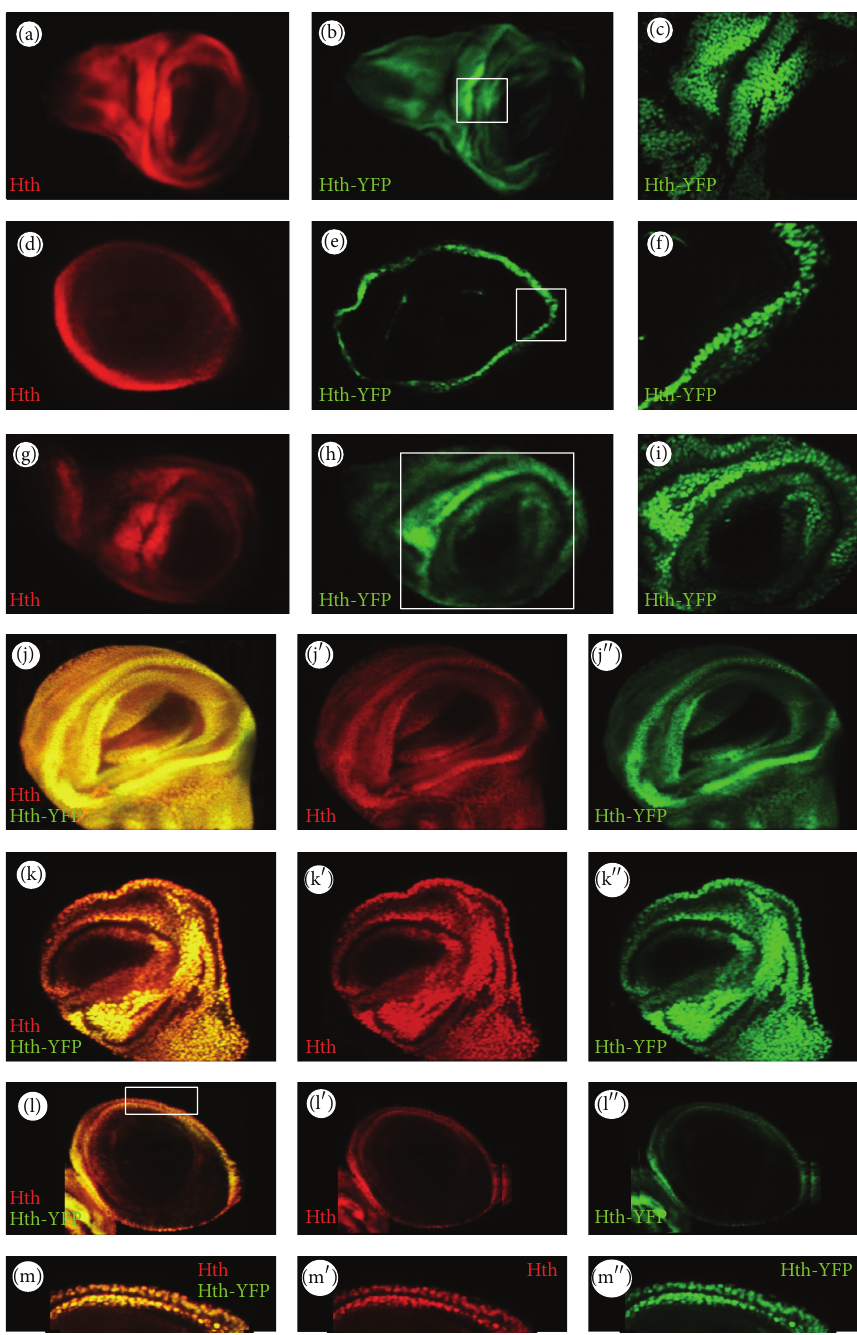
Figure 5: The patterns of Hth expression in T2 and T3 imaginal discs. ((a)–(c)), ((d)–(f)), and ((g)–(i)) are T2 wing, T3 leg, and T3 haltere discs, respectively. ((a), (d), and (g)) The expression patterns of endogenous Hth; ((b), (e), and (h)) the expression patterns of Hth-YFP; ((c), (f), and (i)) the expression patterns of Hth-YFP in the boxed regions in the corresponding images at high magnification showing that the protein trap is nuclear. Double-labelling of Hth-YFP and its endogenous gene shows that they have very similar temporal and spatial expression patterns in wing ((j)–(j 󸀠󸀠 )), haltere ((k)–(k 󸀠󸀠 )), and T3 leg ((l)–(l 󸀠󸀠 )) imaginal discs. ((m)–(m 󸀠󸀠 )) are higher magnifications of the boxed region in